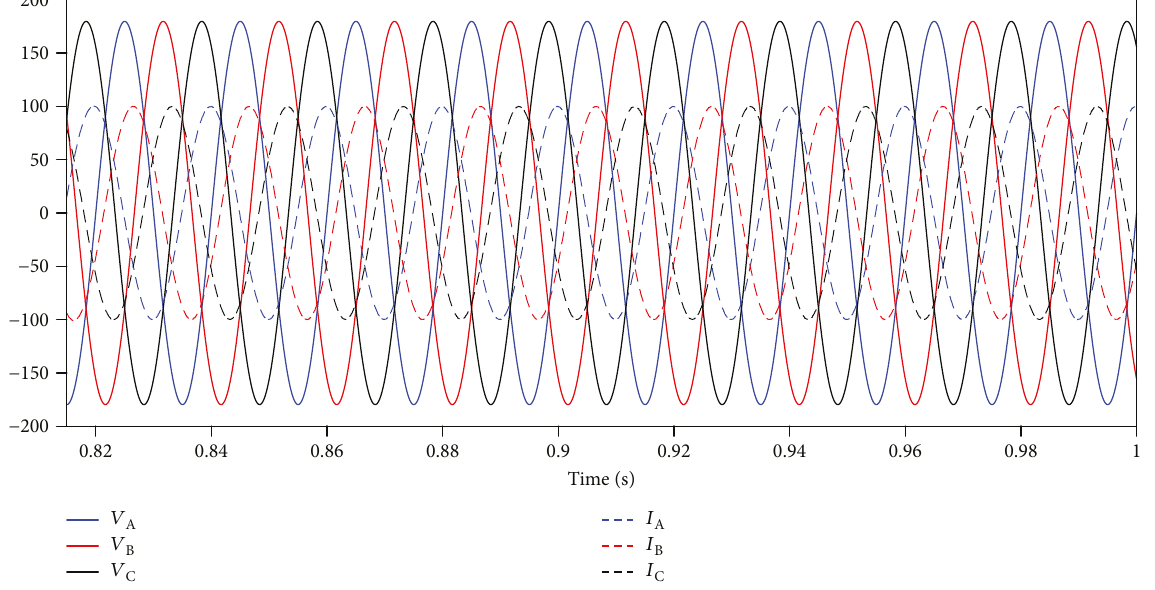
Figure 31: System performance with the increase in the reactive power supply in DSTATCOM